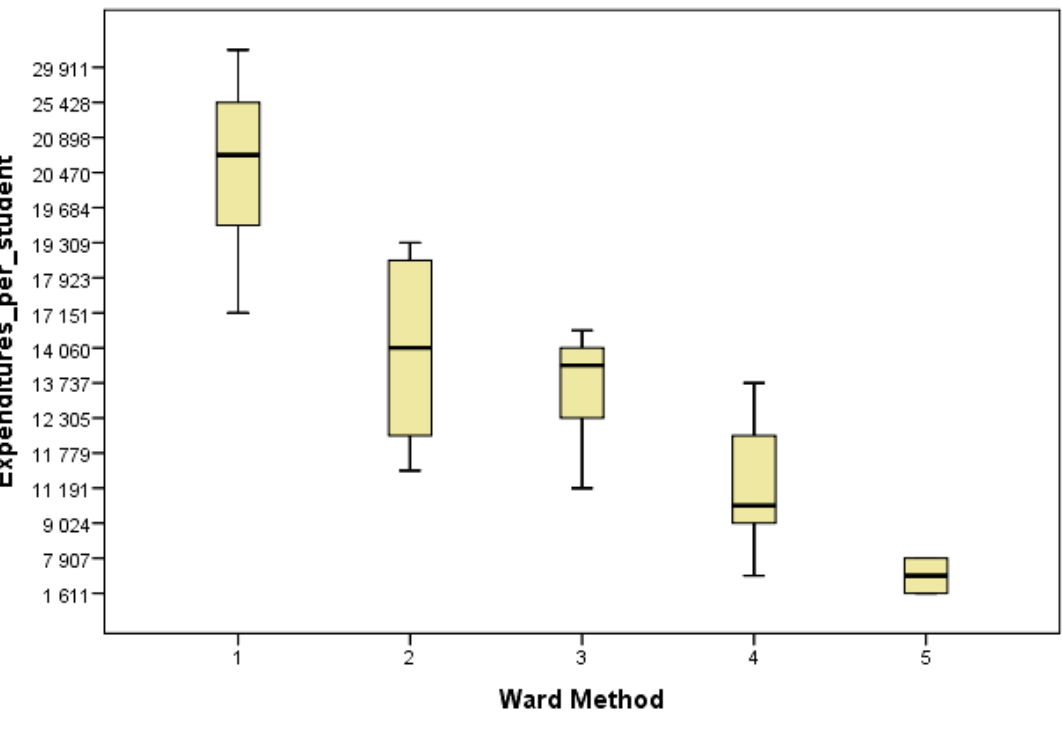
Figure 1. The range of expenditures per student within the clusters in